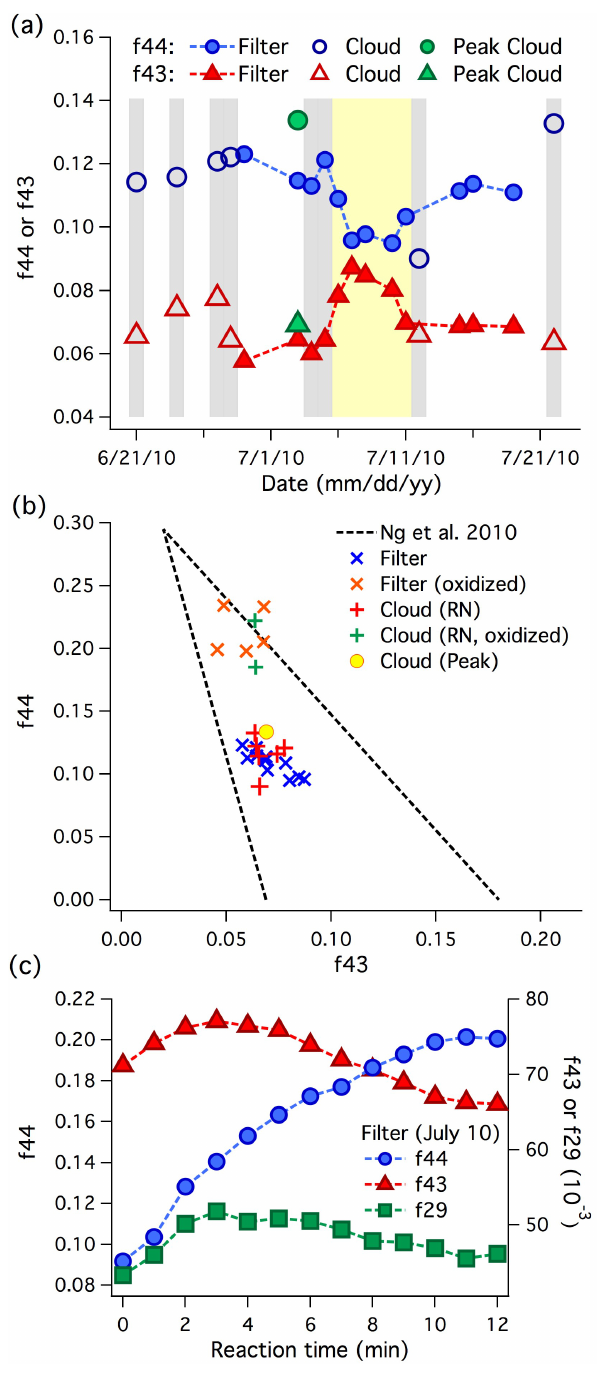
Fig. 3. (a) The f 44 and f 43 profiles of aerosol filter extracts and cloud water samples, (b) Coordinates of aerosol filter and cloud wa- ter samples before and after aqueous-phase OH oxidation on the f 44 vs. f 43 space. The worldwide ambient datasets mainly dis- tributed within the dash line bounded triangular region (Ng et al., 2010). (c) The typical f 44, f 43, and f 29 profiles of filter aerosol extracts during oxidation (10 July